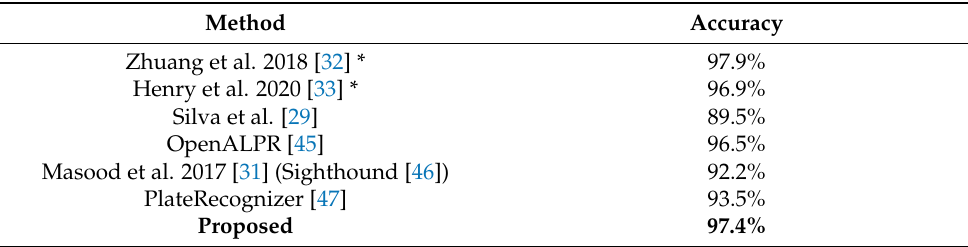
Table 5. Comparison of the proposed mobile ALPR system with the existing methods, using the Media Lab benchmark dataset